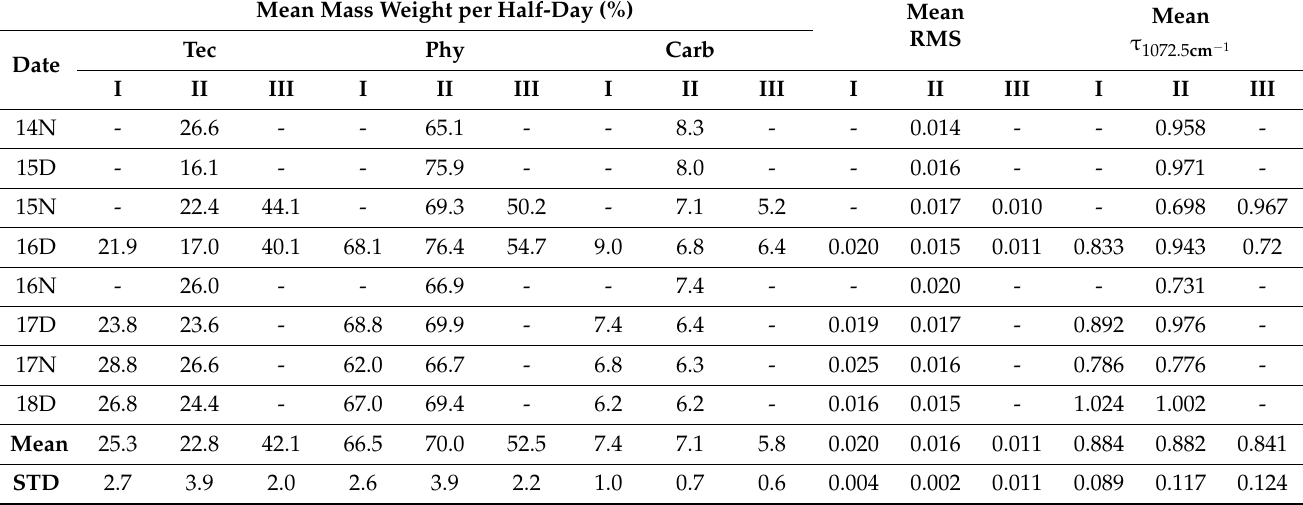
Table 3. The mean mineralogical values and STDs of the three dust type sources in the dust storm of March 2021 in East